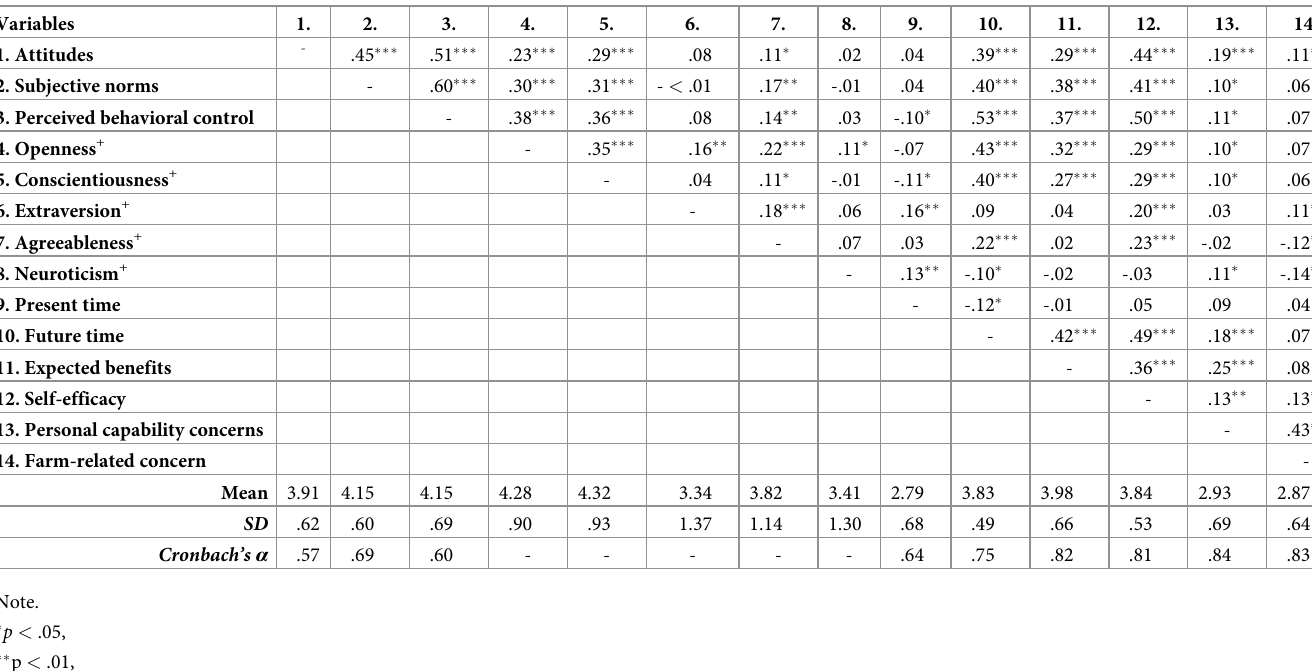
Table 2. Intercorrelations, means, Standard Deviations (SD) and Cronbach’s α s of key study variables for poultry